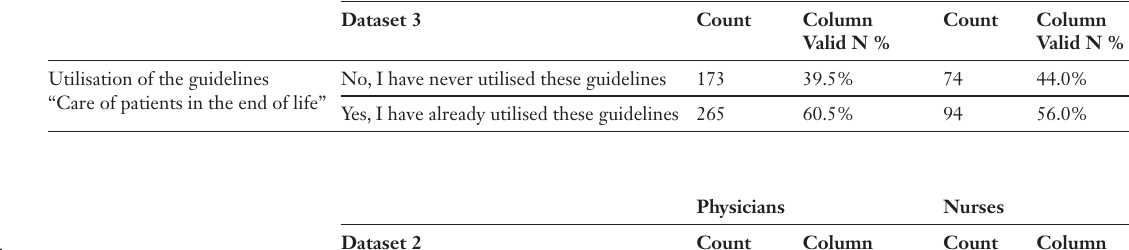
Utilisation of the guidelines “Determi- nation of death in the context of organ transplantation”.